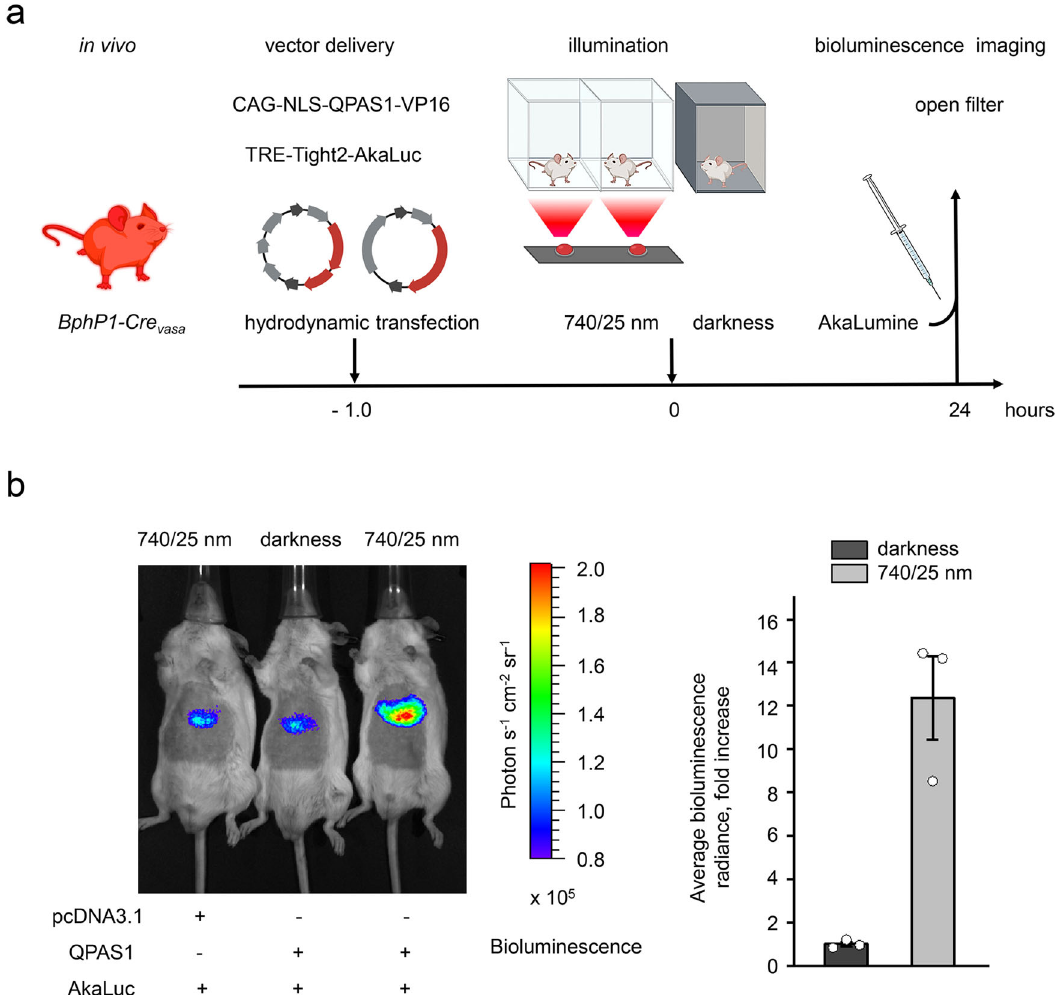
Fig. 4 Optogenetic activation of gene transcription in vivo. a Experimental design for optogenetic transcriptional activation in BphP1-Cre vasa mice. Light- induced expression of AkaLuc was detected after hydrodynamic co-transfection with pAAV-CAG-NLS-QPAS1-VP16 (1.7 μ g) or empty pcDNA3.1 + (1.7 μ g), and pAAV-TRE-Tight2-AkaLuc (8.3 μ g) plasmids. Mice were kept in darkness or illuminated with 740/25nm light of 7.5 mW cm − 2 for 24 h. Animals were injected with AkaLumine-HCl (75 nmol/g of body weight) 15 min before imaging. b In vivo bioluminescence imaging of NIR light-induced expression of AkaLuc in the liver. Visualization was performed in luminescence mode with an open emission fi lter. The light-to-dark ratio for transcription activation of AkaLuc in the liver was calculated after subtraction of background signal produced by the reporter plasmid only (pAAV-TRE-Tight2-AkaLuc with empty pcDNA3.1 + ). Data are presented as mean values + /- SEM ( n = 3; independent transfection experiments). Source data are provided as a Source Data fi